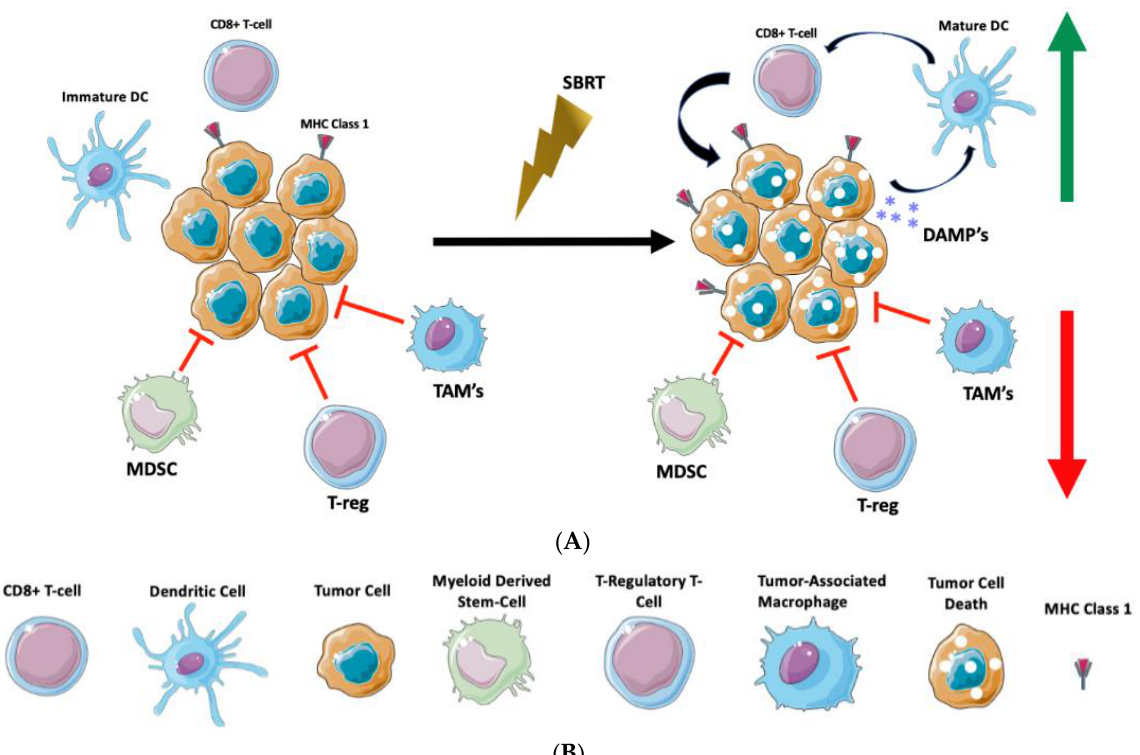
Figure 1. Targeting the Tumor Microenvironment with SBRT. ( A ) Stereotactic Body Radiotherapy offers delivery of highly potent ablative doses of radiation which stimulate expression of MHC class 1 molecules for enhanced tumor recognition, release of tumor damage-associated molecular patterns (DAMP’s) which may lead to maturation of dendritic cells, stimulation of cytotoxic T-cell activity via dendritic-cell antigen presentation, and enhanced anti-tumor immunomodulation. ( B ) Figure Legend.